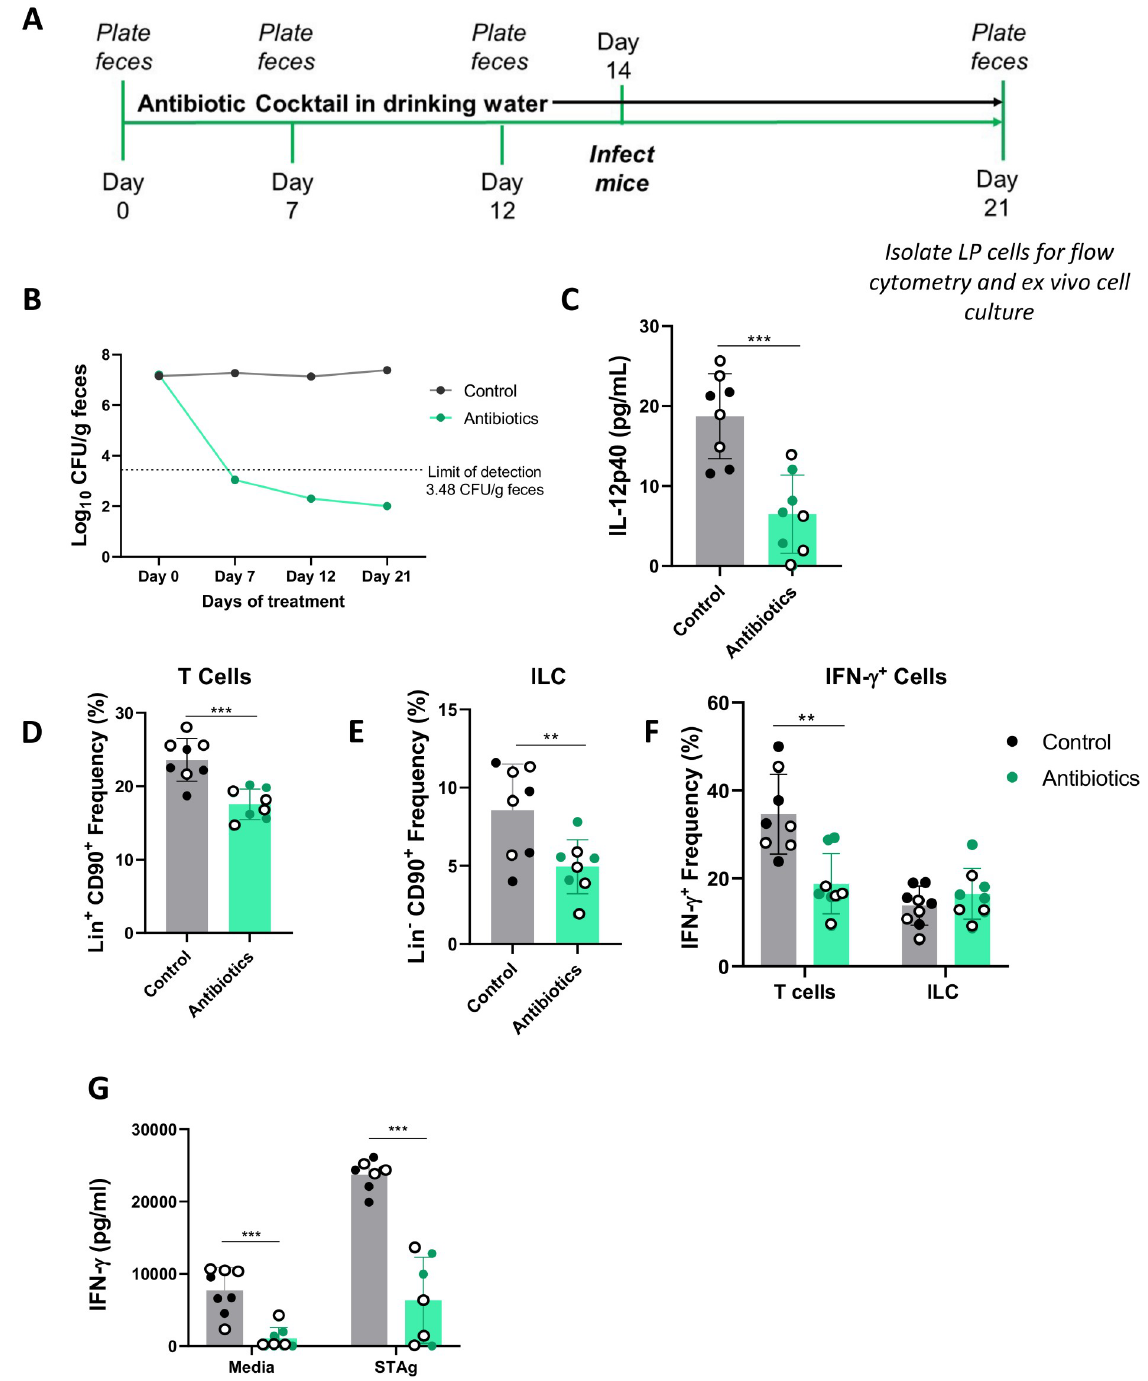
Fig 7. Intestinal microbiota is required for MyD88-independent mucosal immunity against T . gondii . (A) MyD88 -/- mice were treated with antibiotics two weeks prior to and throughout infection. Feces and tissues were collected at time points indicated. (B) Fecal CFU were determined weekly throughout the infection. At day 7 post-infection, tissues were harvested, and LP cells were cultured ex vivo . Supernatants were harvested after 72 hr and (C) IL-12 was quantified. (D) T cell (Lineage + , CD90 + ) and (E) ILC (Lineage - , CD90 + ) frequencies in the LP were determined by flow cytometry. (F) Within the T cell and ILC gates, IFN- γ + frequencies were quantified. (G) IFN- γ levels from ex vivo cell cultures were determined by ELISA. Values are the means ± SEM of two independent experiments. Open and closed symbols indicate animals from independent experiments. An unpaired Student’s t test was used to analyze the data where �� p < 0.01 ��� p < 0.001.